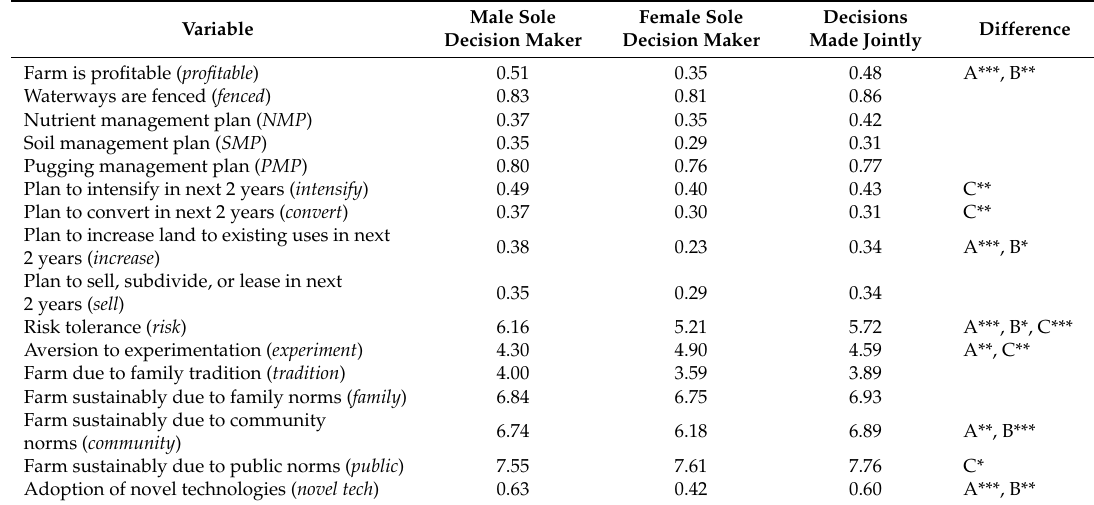
Table 3. Summary Statistics by gender of the decision